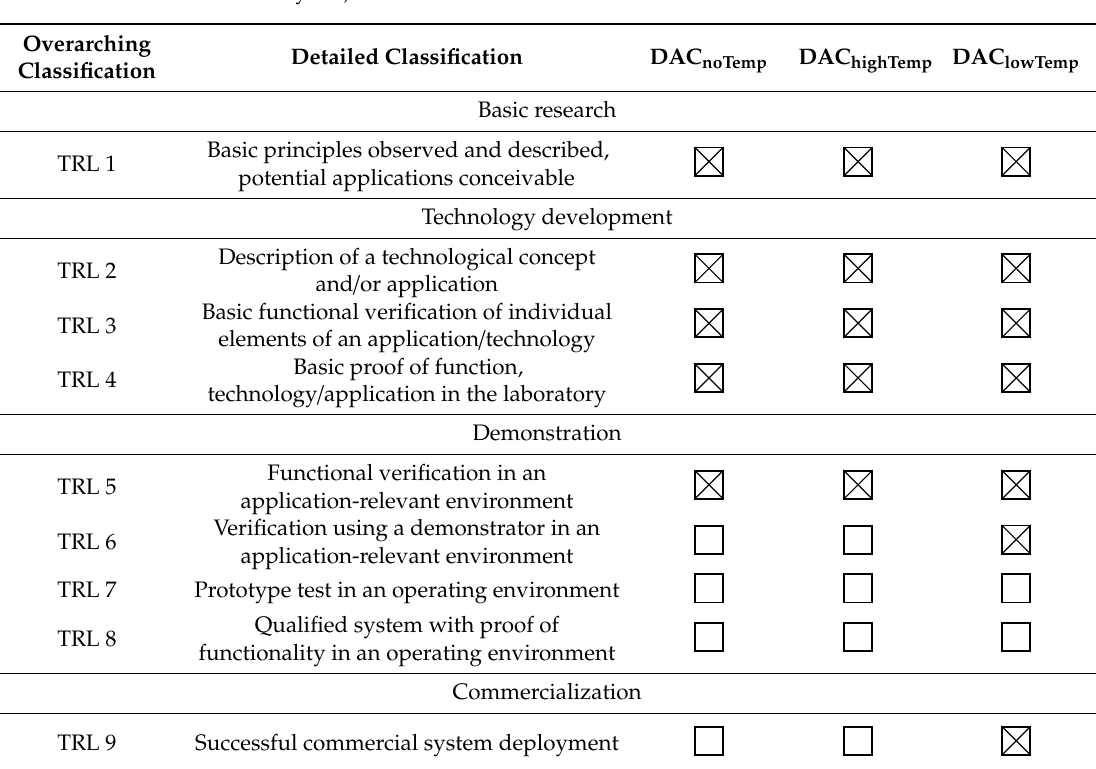
Table 1. Current development stages of Direct Air Capture (DAC) according to their Technology Readiness Level (TRL) (own composition, based on [25,54–57]; boxes are ticked for all TRLs given in the different sources